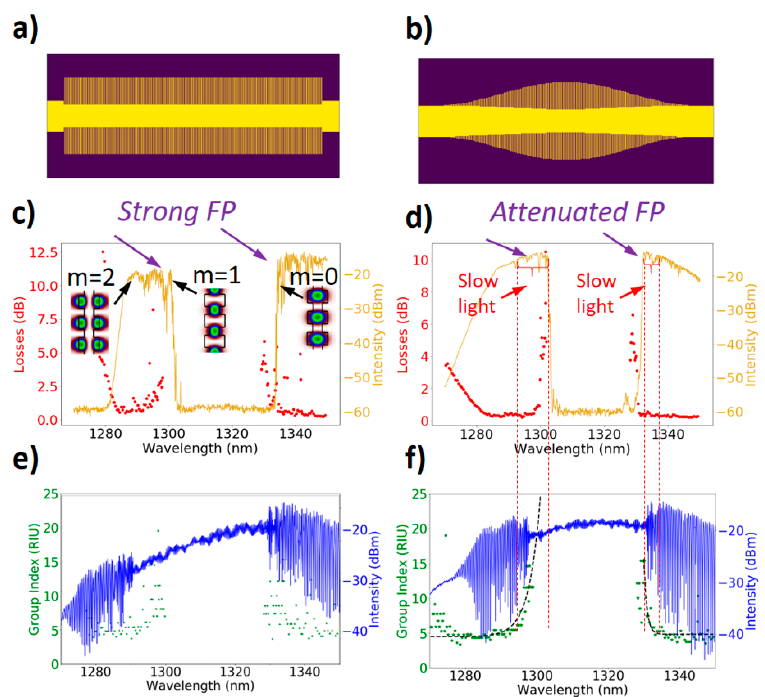
Figure 17. Pictures of the tapered fast-to-slow-light transitions defined by three different apodization functions: ( a ) no fast-to-slow light transition (standard slow light waveguide) and ( b ) Blackman function. ( c , d ) optical transmission vs. wavelength (light brown plain line), losses vs. wavelength (red dots). ( e , f ) Mach–Zehnder Interferometer spectra (blue plain line) from which the group index variations vs. wavelength (exp. data: green dots and fit: dashed black line) are extracted.